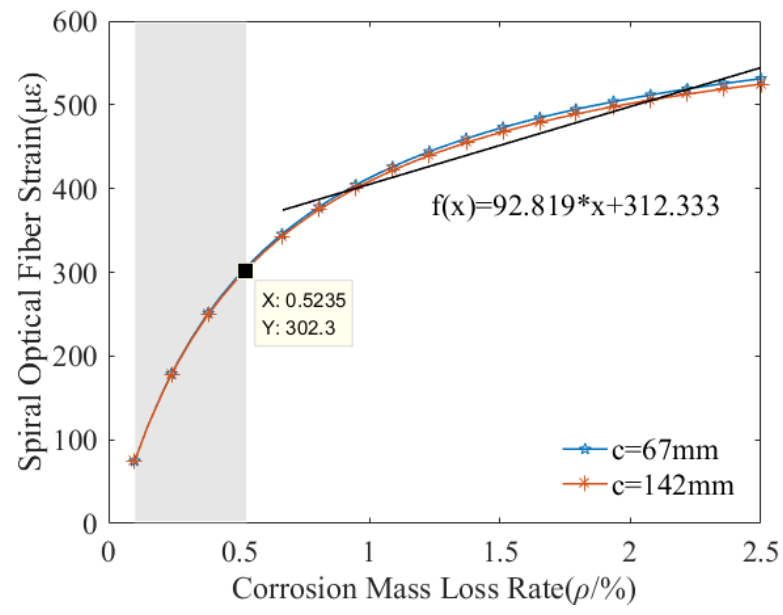
Figure 5. Fiber strain response to corrosion mass loss rate.